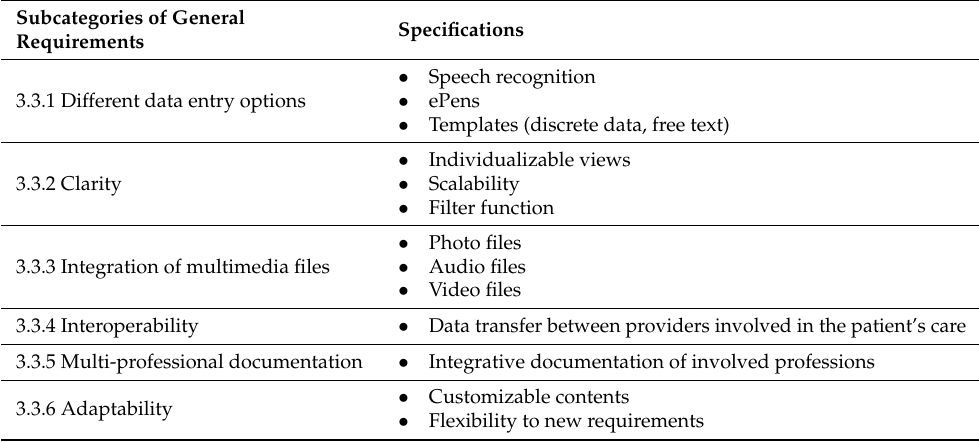
Table 2. General requirements for an electronic health record